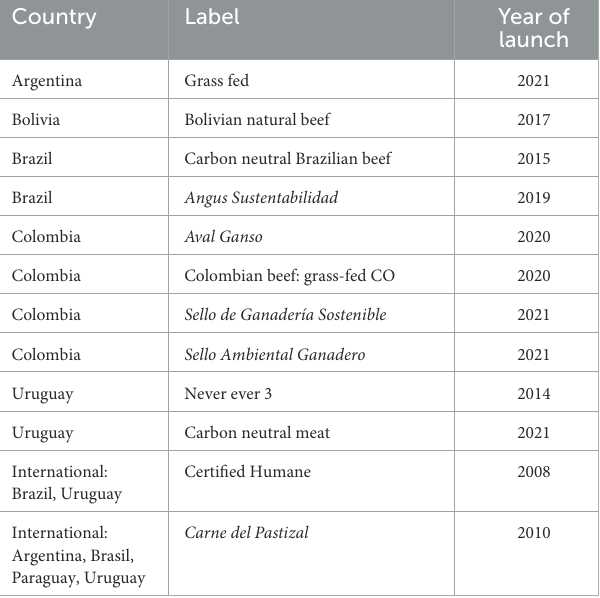
TABLE 2 Identified labels per country in